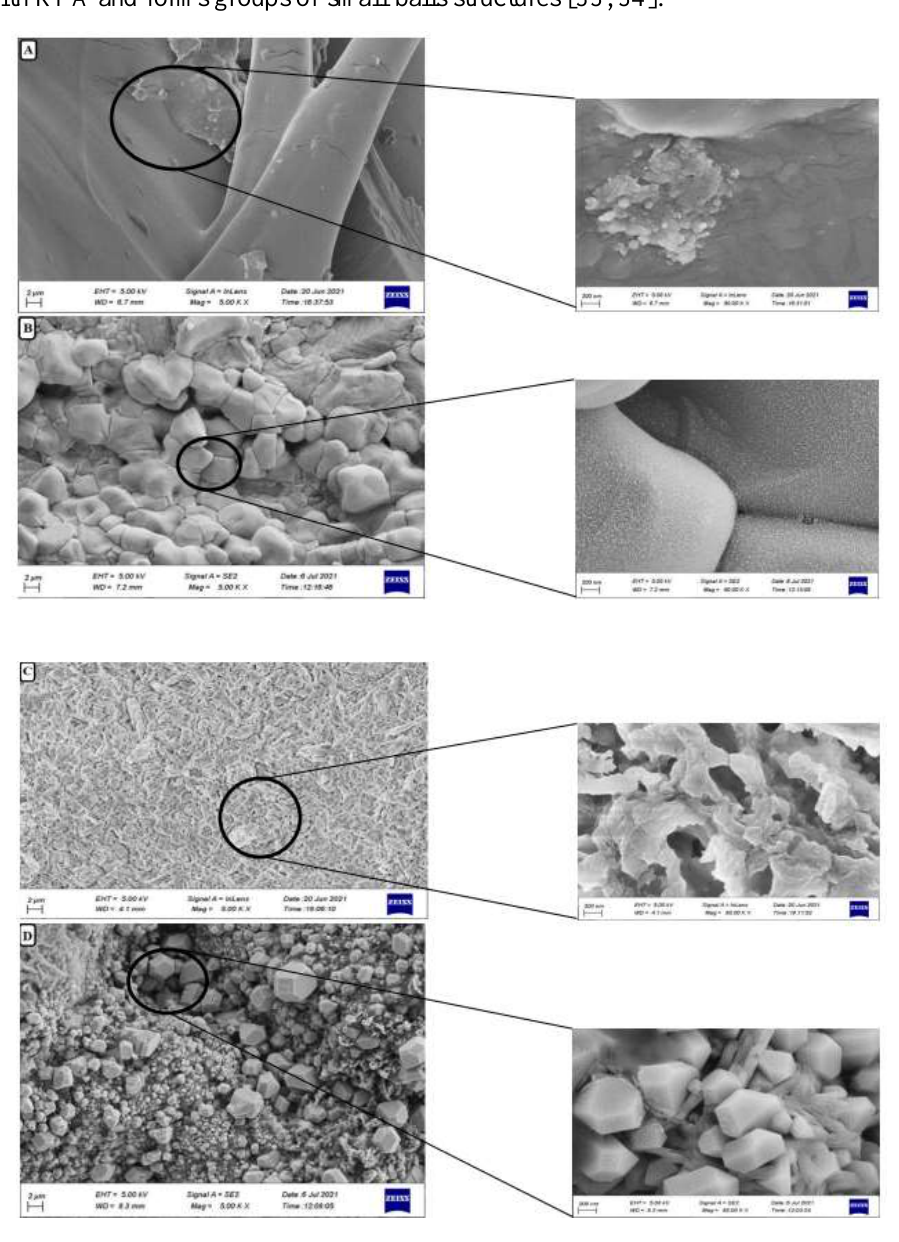
Figure 7: SEM micrographs of (A) KPA, (B) Zn-PA (0.3 g of ZnCl 2) ) (C) PVA and (D) Zn-PVA (0.8 g of ZnCl 2